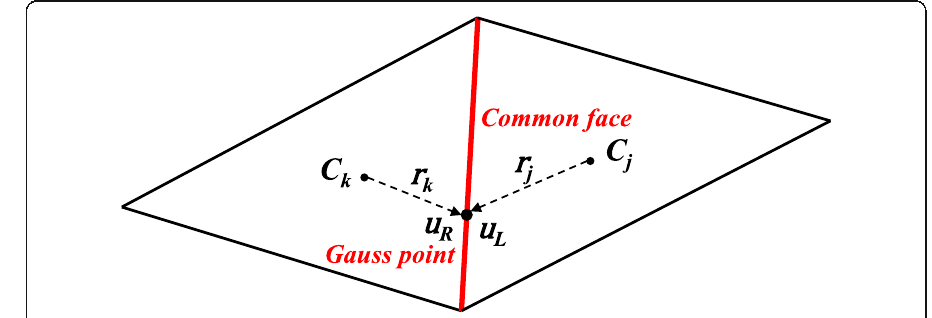
Fig. 1 Diagram of unstructured finite volume